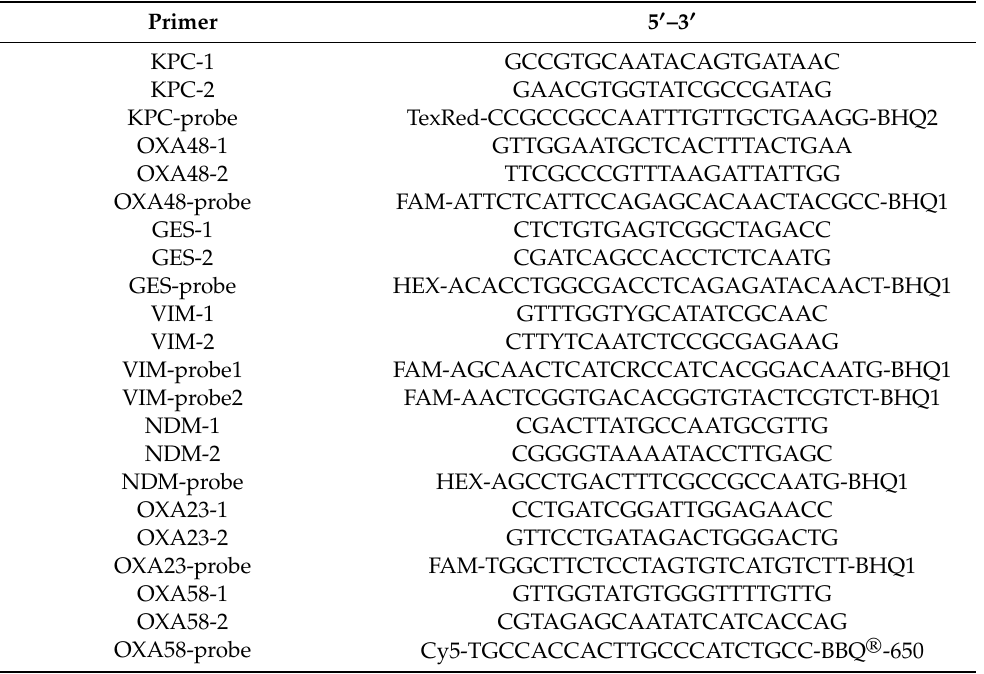
Table 1. Primers used for the detection of genes encoding beta-lactamases ( bla ) and mobile colistin resistance ( mcr